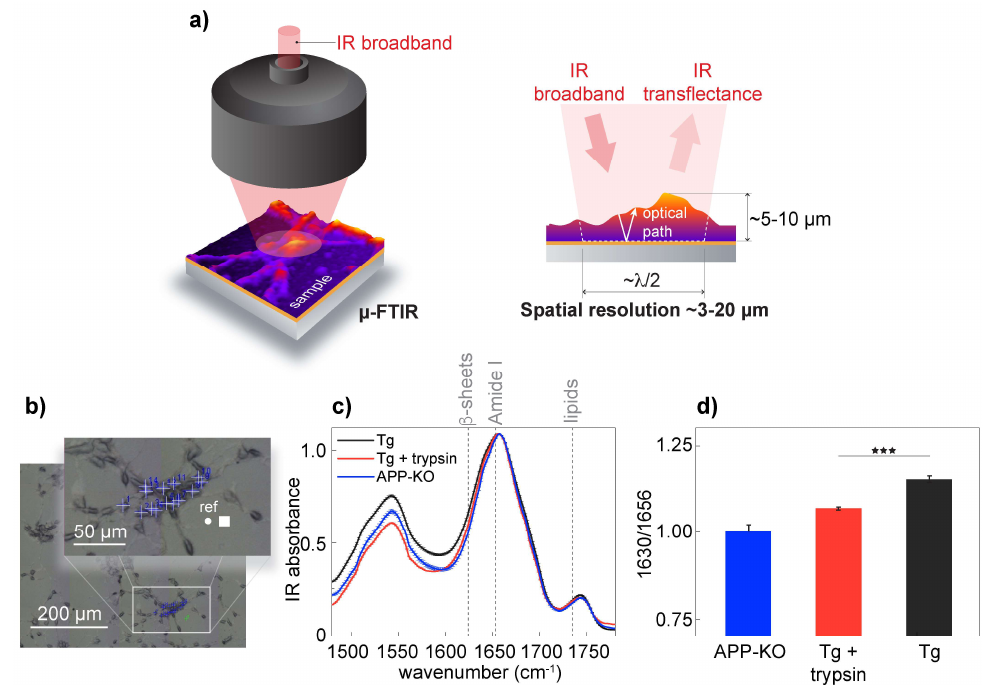
Figure 2. Fourier-transform infrared ( µ -FTIR) point spectral analysis. ( a ) Schematic diagram of the working principle, penetration depth, and lateral resolution of µ -FTIR. For µ -FTIR reflectance geometry (right panel), the IR beam is focused on the sample, whose spot size is comparable to the illumination wavelength (diffraction-limited, 3–20 µ m). The sampling depth is usually defined by the IR optical path inside the sample (~5–10 µ m). ( b ) A bright-field visible-light image of cultured primary neurons. The white square in the digital insert shows the apertures used during the synchrotron-based µ -FTIR measurements. A white square indicates the aperture set to 8 × 8 µ m 2 and indicates the background position; Crosses show the position for spectra acquisition. ( c ) Averaged and normalized IR absorption spectra from untreated APP/PS1 transgenic neurons (red), APP/PS1 transgenic neurons (green), and APP-KO (black). Each point spectrum is an average of 256 spectral scans. FTIR spectra were acquired from different neurons (10 to 15 cells per condition), *** corresponds to p < 0.001 ( d ) Averaged and normalized second derivatives of the absorbance spectra mentioned in ( c ) show changes in the intensity at the 1630 cm − 1 position (arrow). µ -FTIR spectra were acquired at 2 cm − 1 spectral resolution with 256 averages in transmission mode. Statistics: a paired t -test for comparing two groups, *** indicates a significant difference at p <